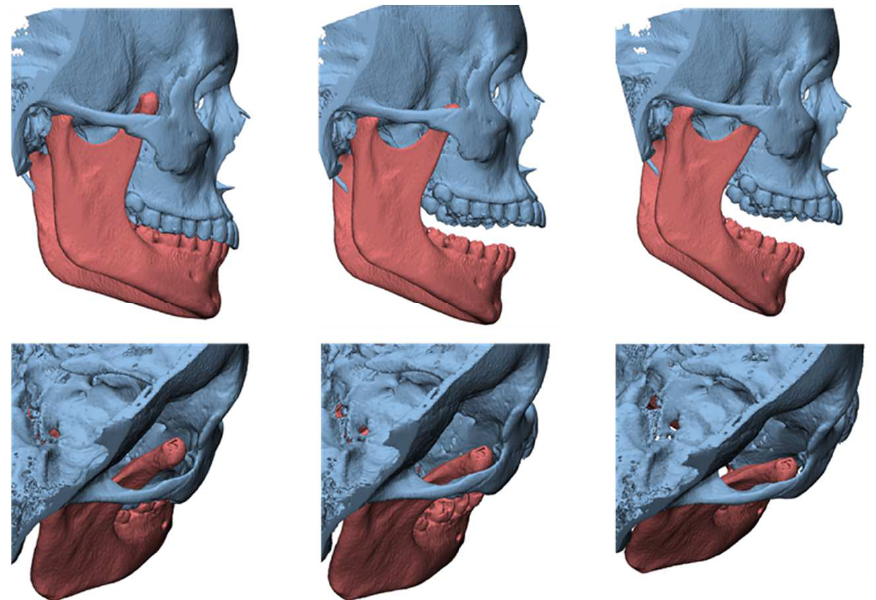
Figure 2. Cinematic 3D reconstruction (Mimics, Materialise NV, Leuven, Belgium) showing the pseudojoint established between the altered right CPM and the inner aspect of zygomatic bone.